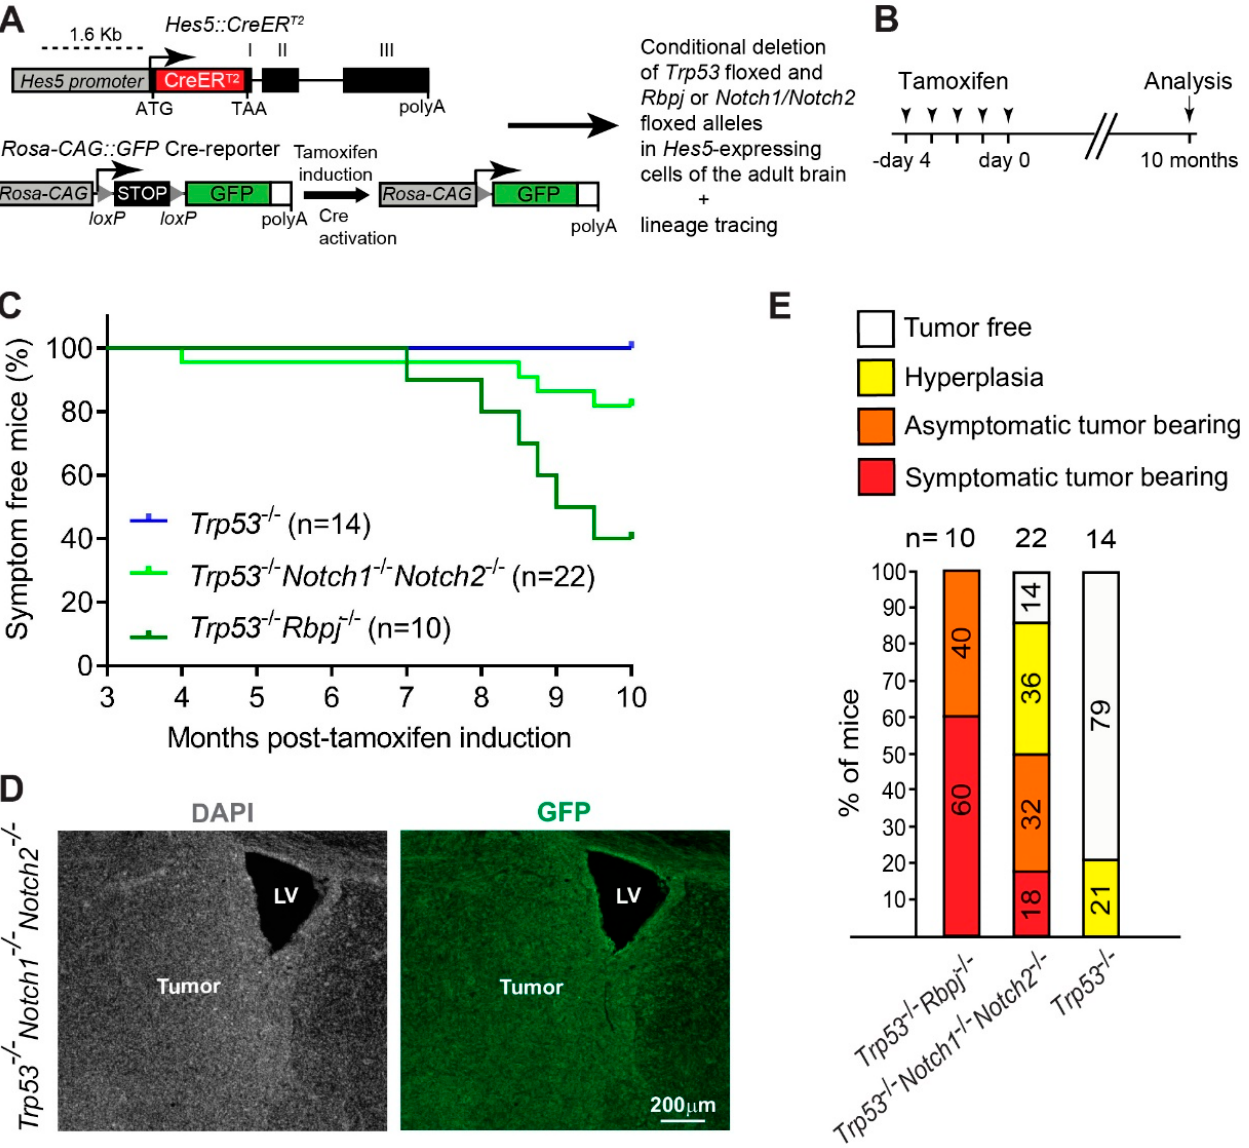
Figure 1. Combined Notch1/Notch2 and Trp53 deletion in Hes5 + cells leads to formation of forebrain tumors in adult mice. ( A , B ) Conditional deletion of Notch1 , Notch2 and Trp53 or Rbpj and Trp53 in brain cells expressing the Notch target gene Hes5 . Adult Hes5::CreER T2 mice carrying floxed Trp53 alleles and either floxed Notch1 and Notch2 alleles or floxed Rbpj alleles and a GFP Cre-reporter for lineage tracing were treated with tamoxifen ( A ) and were analyzed 10 months later ( B ). ( C ) Kaplan–Meier curves showing survival of Hes5::CreER T2 Trp53 -/- , Trp53 -/- Notch1 -/- Notch2 -/- and Trp53 -/- Rbpj -/- mutant mice. ( D ) A Trp53 -/- Notch1 -/- Notch2 -/- tumor in the forebrain. The GFP expression from the Rosa-CAG::GFP Cre-reporter indicates derivation from Hes5 + cells. LV, lateral ventricle. ( E ) Percentages of Trp53 -/- , Trp53 -/- Notch1 -/- Notch2 -/- and Trp53 -/- Rbpj -/- mice that developed hyperplasia or tumors in the